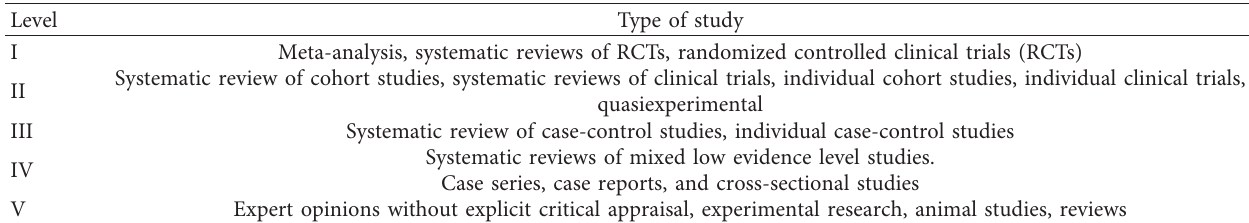
Table 1: The modified Oxford’s level of evidence scale.